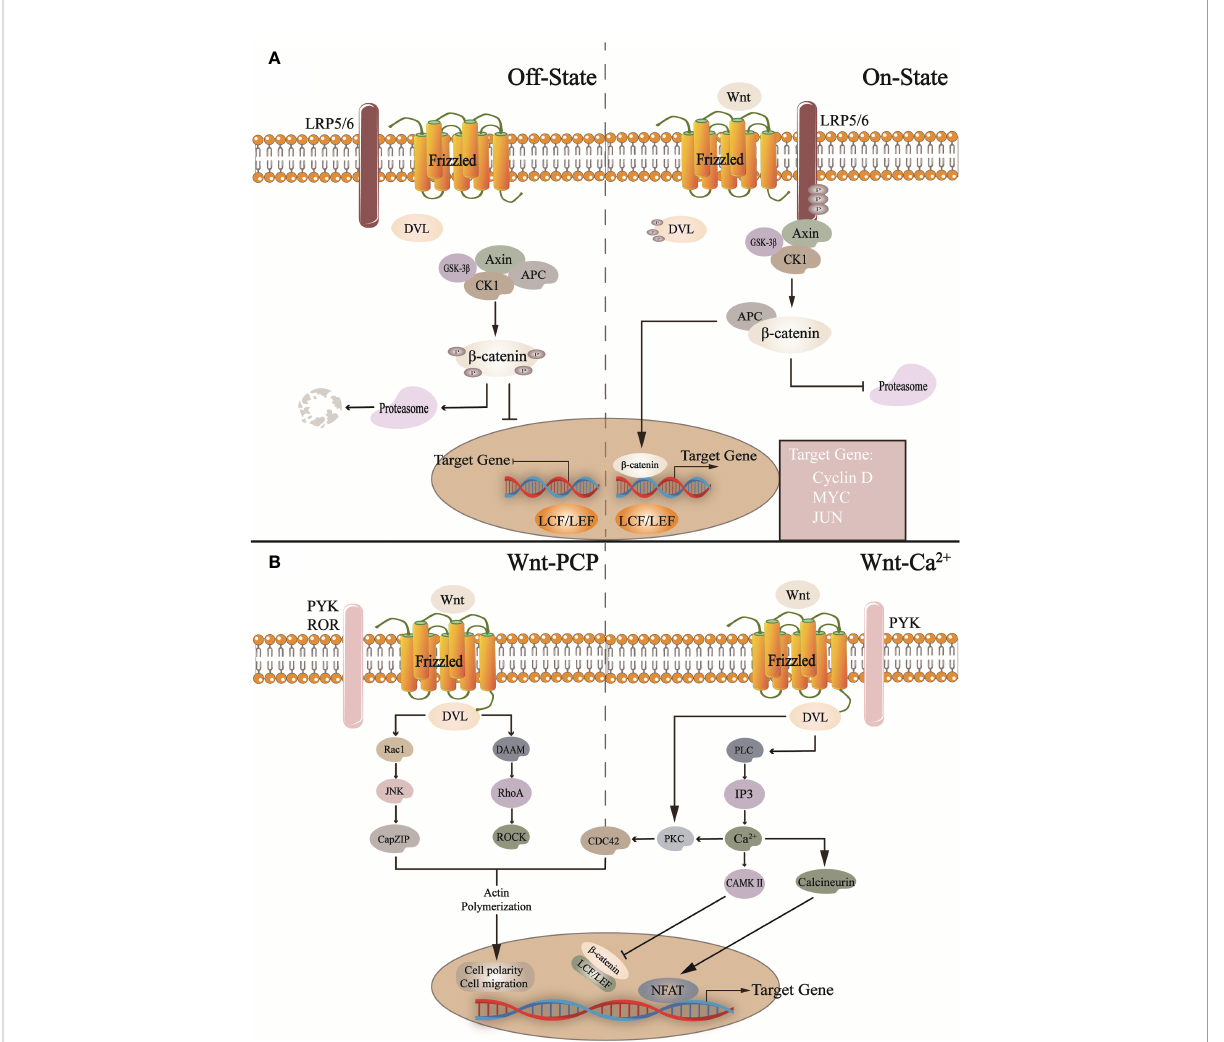
FIGURE 2 In the canonical Wnt pathway (A) : In the absence of Wnt activation, the cytoplasmic b -catenin is phosphorylated by the destruction complex (Axin, CK1, GSK-3 b , APC) and then degraded by proteasome after a series of reactions. When Wnt binds to Frizzled and LRP5/6 receptors, it activates DVL, inactive GSK-3 b , and inhibits proteasome degradation b -catenin, and b -catenin translocates into the nucleus and binds with LCF/ LEF to regulate target gene transcription. In the non-canonical Wnt pathway. CK1, casein kinase 1; GSK-3b, glycogen synthase kinase 3 b ; APC, adenomatous polyposis coli; LPR5/6, low-density lipoprotein-related receptors 5 and 6; DVL, Dishevelled. (B) In the Wnt/PCP pathway, Wnt binds to other receptors (such as ROR, RYK, etc.), activates DVL, and promotes downstream pathway transduction, such as Roc1, JNK, etc. This is related to cell migration and cell polarity. In addition, in the Wnt/Ca 2+ pathway, it activates phospholipase C (PLC), triggers intracellular Ca 2+ release, and regulates NFAT and b -catenin, which regulates the expression of related genes. Roc1, regulator of cullins 1; JNK, c-Jun N-terminal kinase; CapZIP, CapZ-interacting protein; DAAM, Dishevelled associated activator of morphogenesis; RhoA, Ras homolog gene family member A; ROCK, Rho-associated, coiled-coil containing kinases; PLC, phospholipase C; IP3, inositol 1,4,5-trisphosphate; PKC, protein kinase C; CAMKII, calcium/calmodulin-dependent protein kinase II; NFAT, nuclear factor of activated T-cells; PYK, RYK receptor-like tyrosine kinase; ROR, receptor tyrosine kinase-like orphan